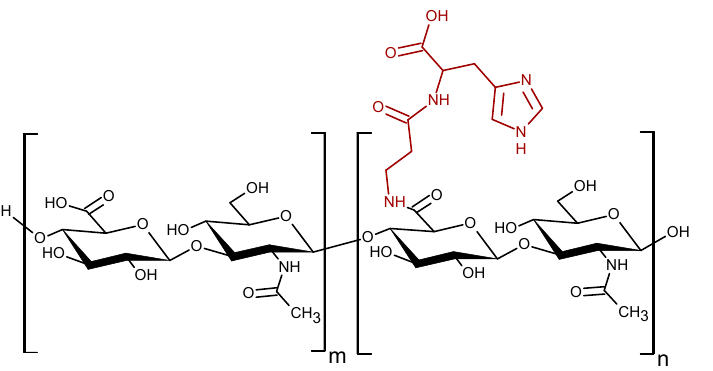
Figure 1. Schematic structure the HyCar derivatives. The n and m are the average number of repeat units conjugated or not to Car, respectively.